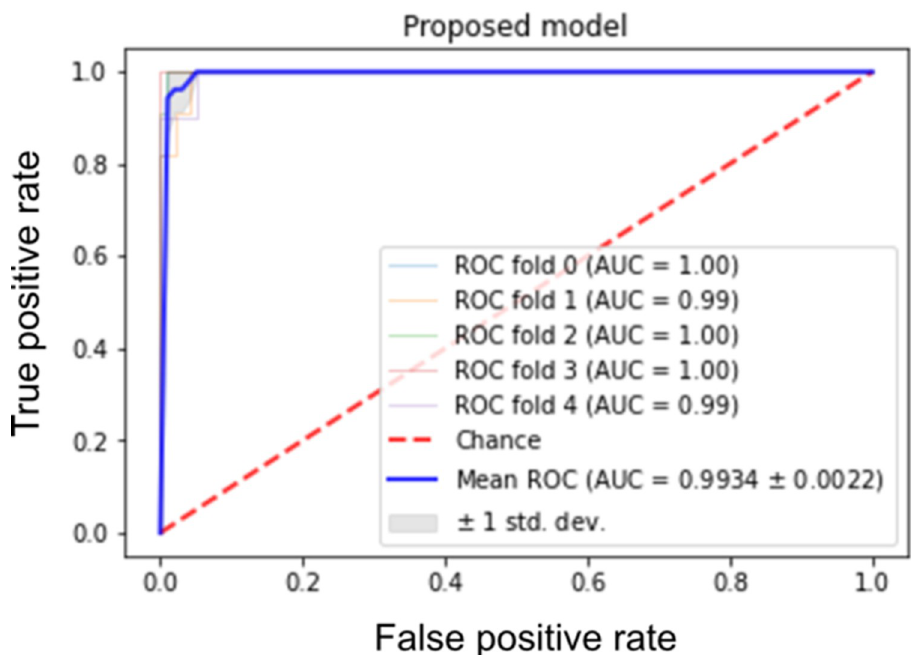
Fig 5. ROC and AUC analysis. Using the proposed model of the 12 candidate biomarkers with stratified 5-fold cross- validation.